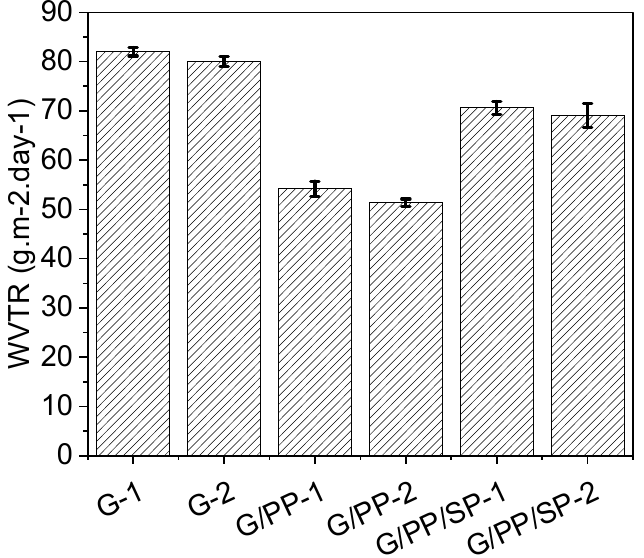
Figure 9. Effect of gelatin, papaya, and soy protein on water vapor transmission rate (WVTR) of edible films.